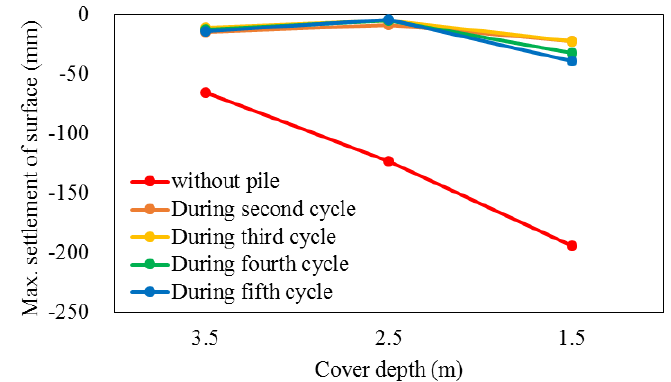
Figure 16. Displacement of ground surface during Stage 1 of each construction cycle based on cover depth.